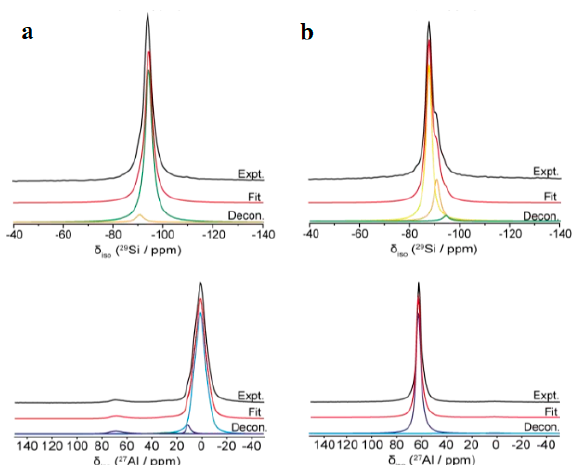
Figure 4. 29 Si Magic-Angle Spinning Nuclear Magnetic Resonance data ( top ) and 27 Al MAS NMR data ( bottom ) spectra of ( a ) raw kaolin and ( b ) metakaolin.